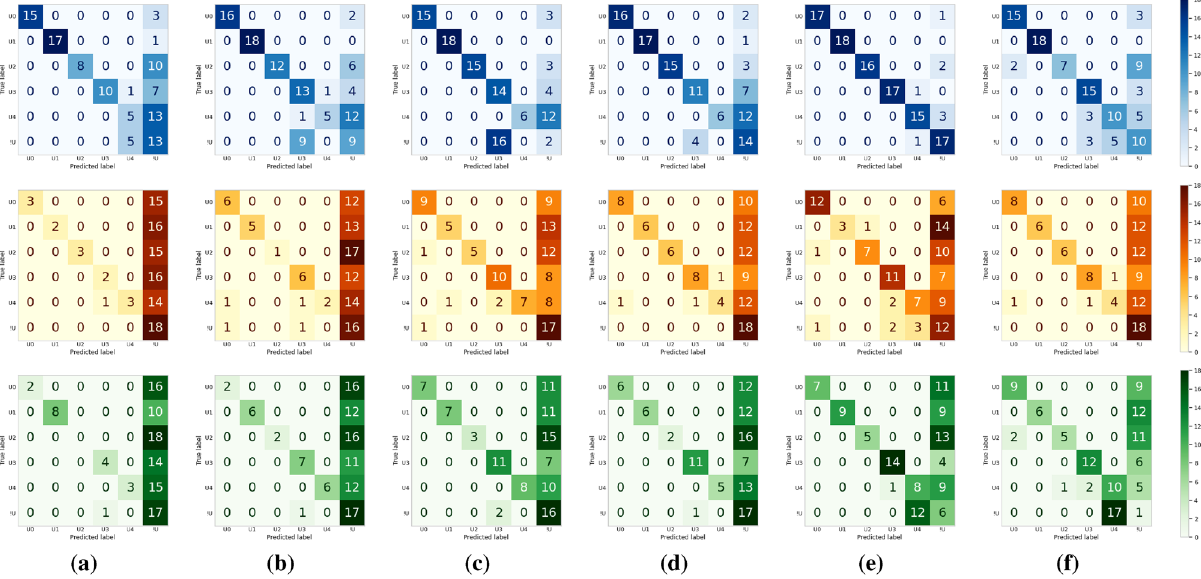
Figure 6. Confusion matrices for each architecture: Custom in blue (first row), LeNet in brown (second row) and AlexNet in green (third row). From left to right the different configurations used: ( a ) C 5 × 0 , ( b ) C 5 × 1 , ( c )